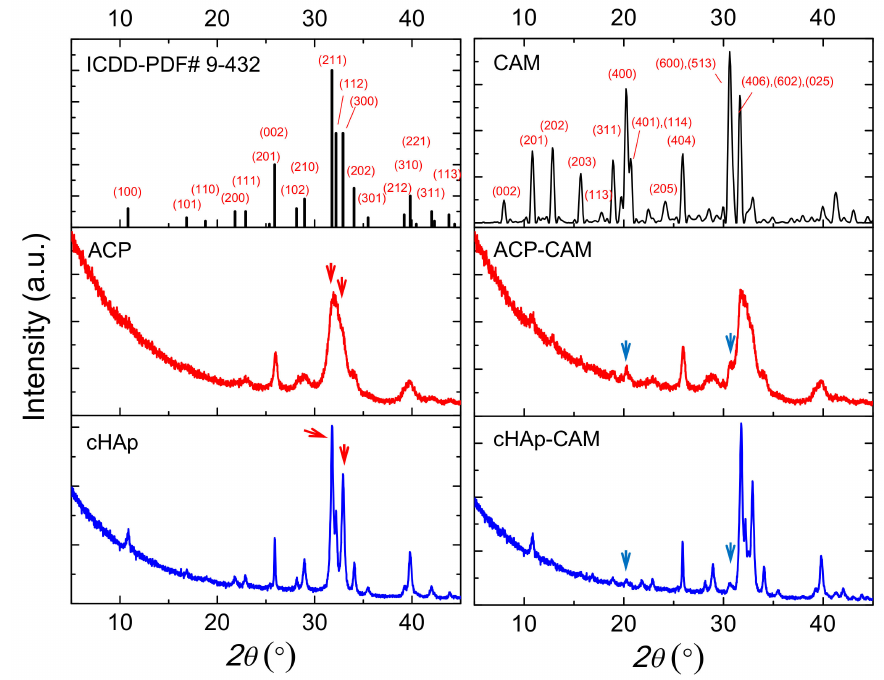
Figure 3. X-ray di ff raction patterns of the reported di ff raction pattern of hydroxyapatite (ICDD number 9-432), CAM, ACP nanoparticles, ACP-CAM nanoparticles, cHAp nanoparticles, and cHAp-CAM nanoparticles. Blue arrows point out the (401) + (114) and (600) + (513) reflections of CAM, while red arrows indicated the (211) and (300) reflections of ACP and